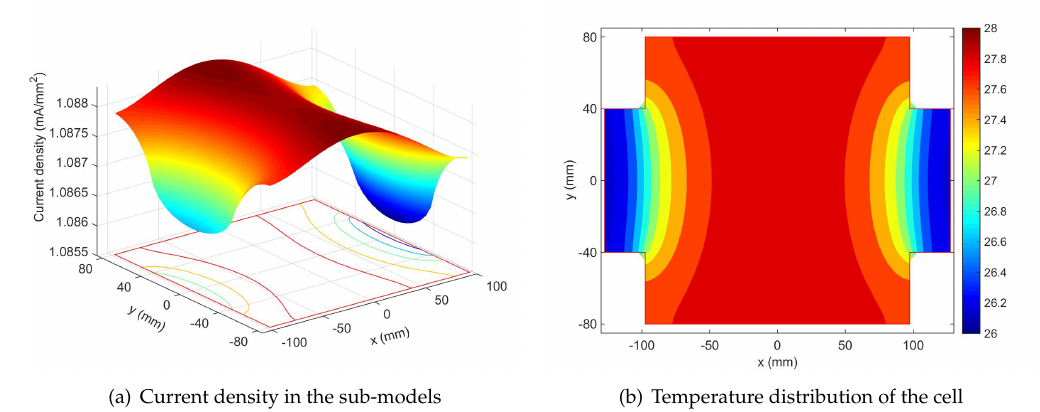
Figure 14. Non-uniformity at the end of the 1C